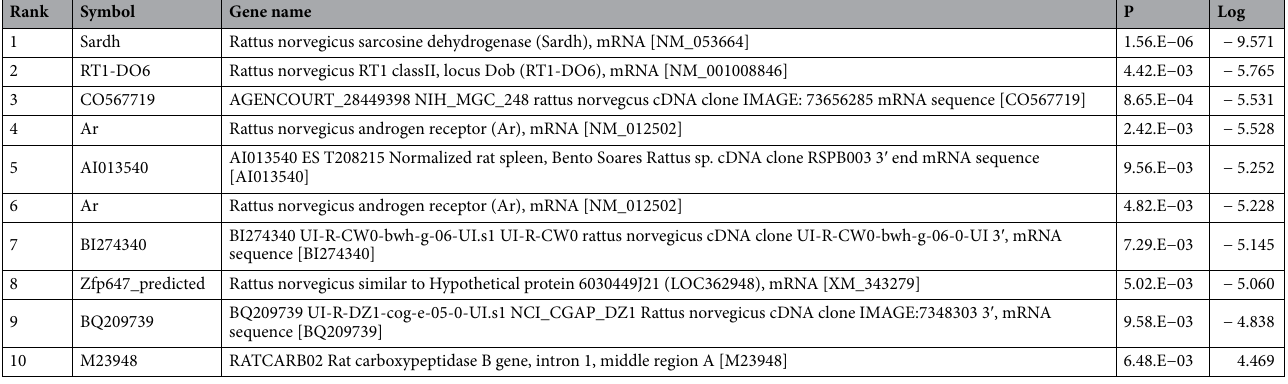
Table 2. Genes affected by dysfunctional Smek2 in ExHC